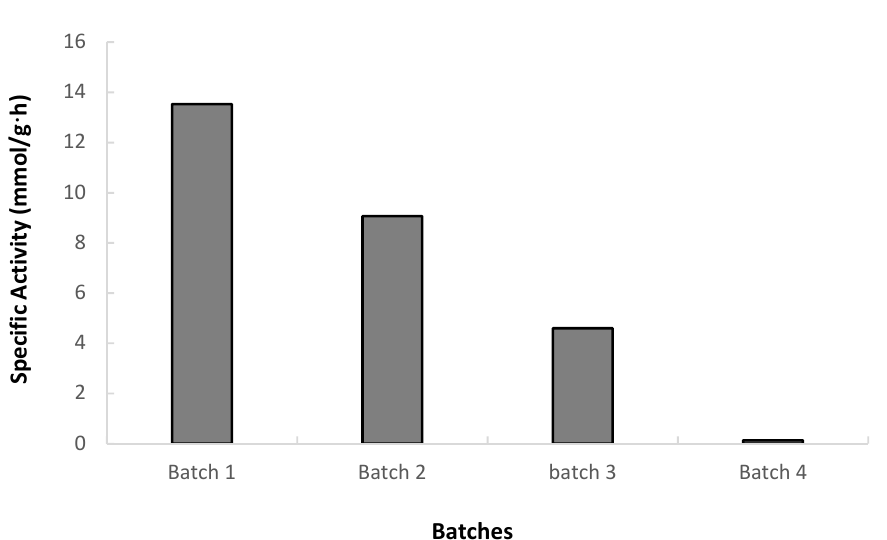
Figure 5. Specific activity during the operation of sequential enzymatic reactors with monophasic first-order inactivation kinetics, k d = 0.02 h − 1 .